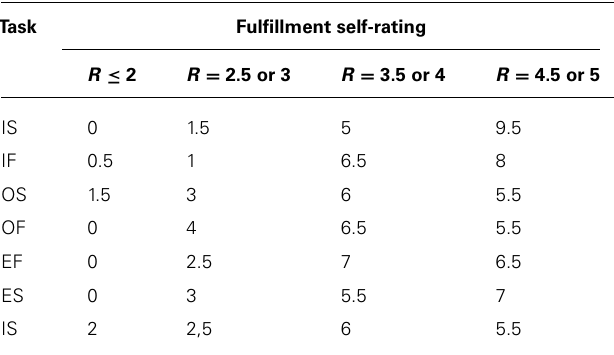
Table 6 |The average number of the 16 participants with the self-ratings for each task is